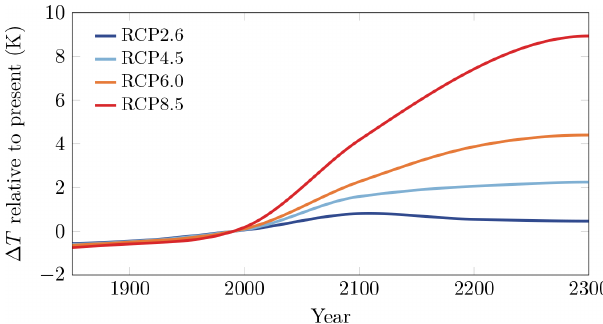
Figure 2. Long-term RCP temperature scenarios (Golledge et al., 2015) for Antarctica (60–90 ◦ S) based on the CMIP5 data (Taylor et al., 2012) and extended to 2300. Temperatures are held constant after